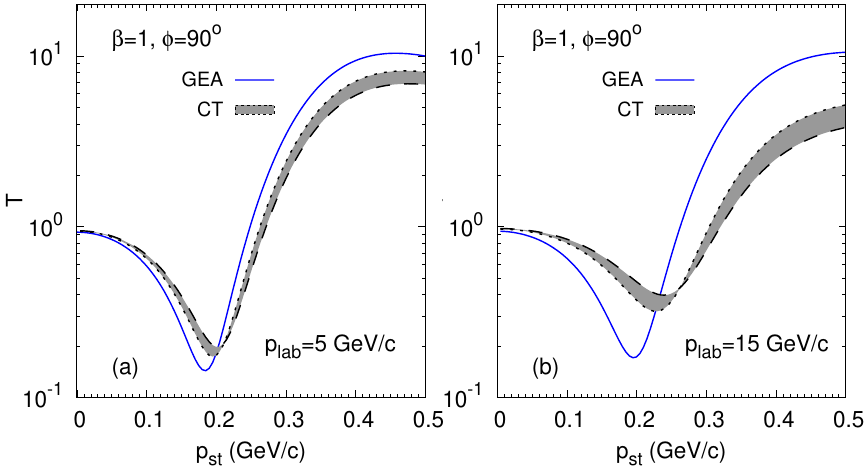
Figure 3. Transparency ratio, Equation (16), for the process ¯ pd π − π 0 p as a function of the → transverse momentum of the spectator proton for α s = 1, β = 1, φ = 90 ◦ at ( a ) p lab = 5 GeV/ c and ( b ) p lab = 15 GeV/ c . The generalized eikonal approximation (GEA) calculation is shown by the solid line. The calculations with CT are displayed by the gray band, limited by the values of the mass denominator of the coherence length ∆ M 2 = 0.7 GeV 2 (dashed line) and 1.1 GeV 2 (dotted line). All calculations include ¯ p and pion rescattering